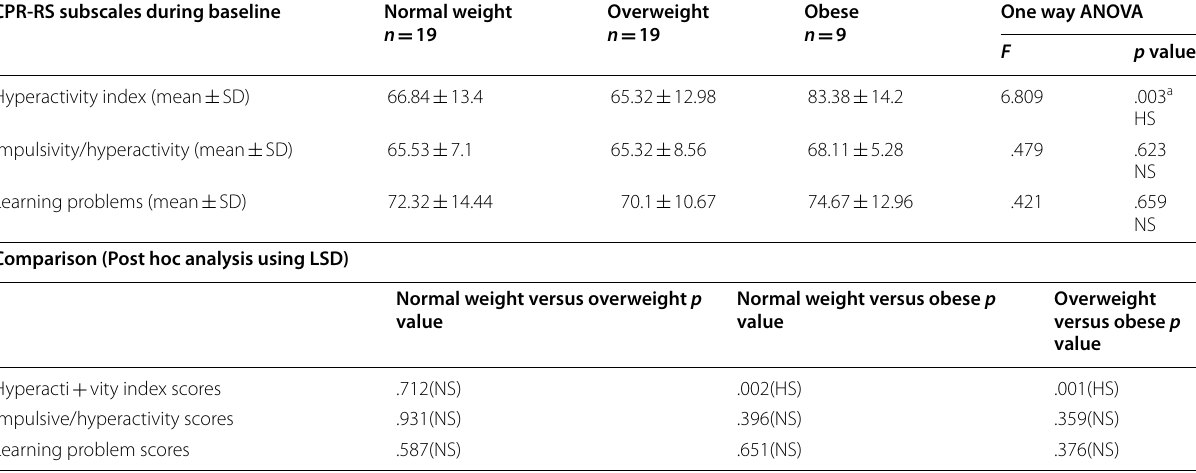
NS non-significant ( p > .05), HS highly significant ( p < .01) a Highly significant ( p < .01)